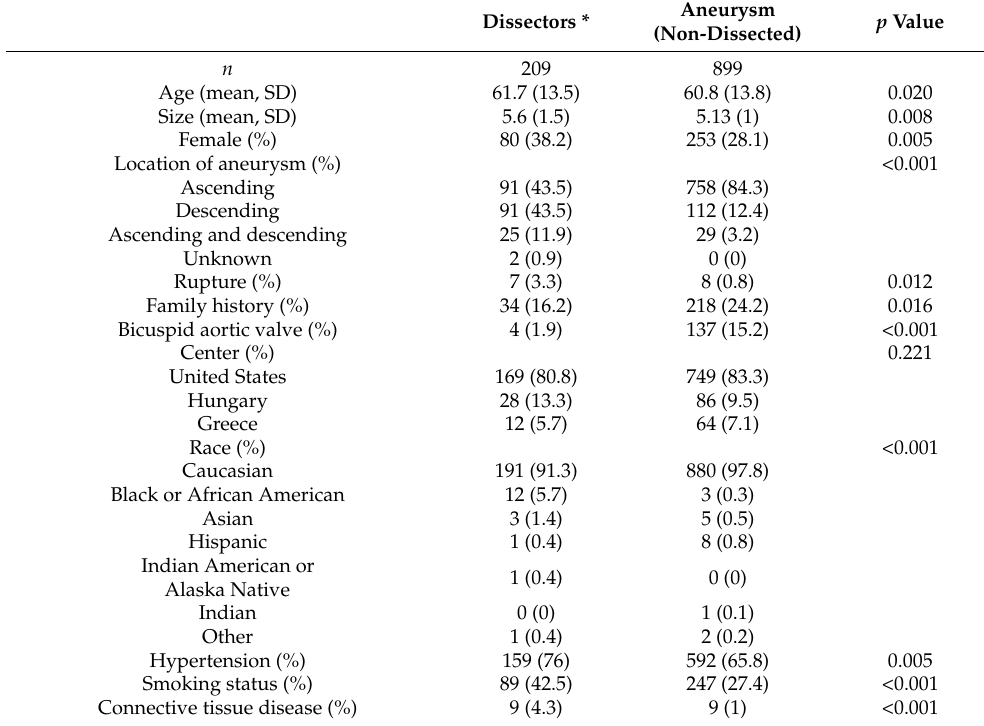
Table 1. Patient